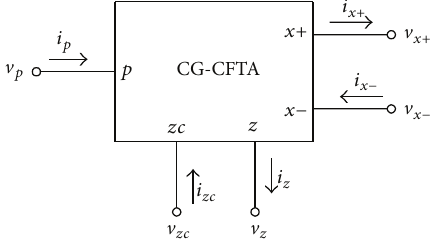
Figure 7: Circuit symbol of the proposed